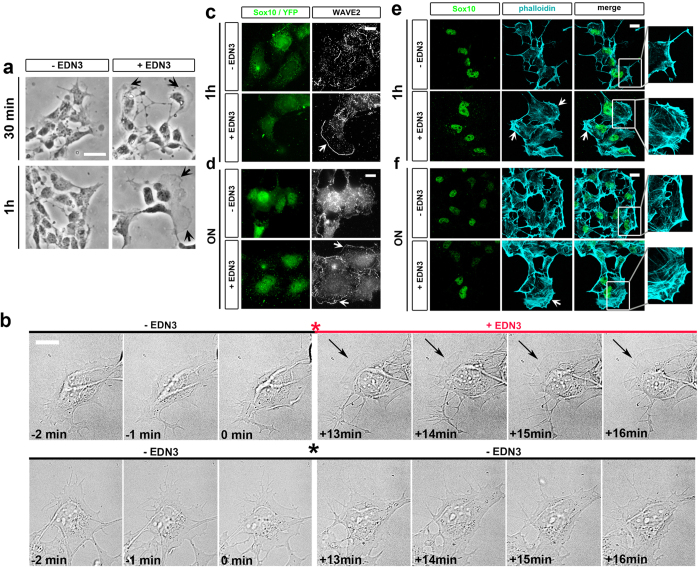
EDN3 favours a sustained growth of ENCC protrusions.(a) Phase contrast images showing spread ENCCs with lamellipodia (black arrows) on FN after 30 min or 1 h of EDN3 treatment, or in control medium. Scale bar = 50 μm. (b) Images extracted from a time-lapse movie of gut explant cultures in control medium immediately before, and 13 min after, the change of medium (indicated by an asterisk) for medium with (red line) or without (black line) EDN3. The upper and lower right panels in b were extracted from the movies 1 and 2 (see supplementary Videos), respectively. After stimulation with EDN3, a lamellipodium start to grow on the ENCC (black arrows, upper panels), but not after incubation with control medium (lower panels) for the same period. (c,d) lamellipodium edge of ENCCs (Sox10+/YFP+) stained with WAVE2 antibody (white arrows) after a 1 h (c) or overnight (ON, d) EDN3 treatment. (e,f) Confocal images showing ENCCs (Sox10+/YFP+), F-actin (phalloidin) staining, and showing the reorganisation of the actin cytoskeleton at the lamellipodium edge (white arrows) after an overnight (e) or 1 h EDN3 treatment (f). The organisation of the actin cytoskeleton is shown at a higher magnification in the inserts. Scale bars in (b–e) = 10 μm.